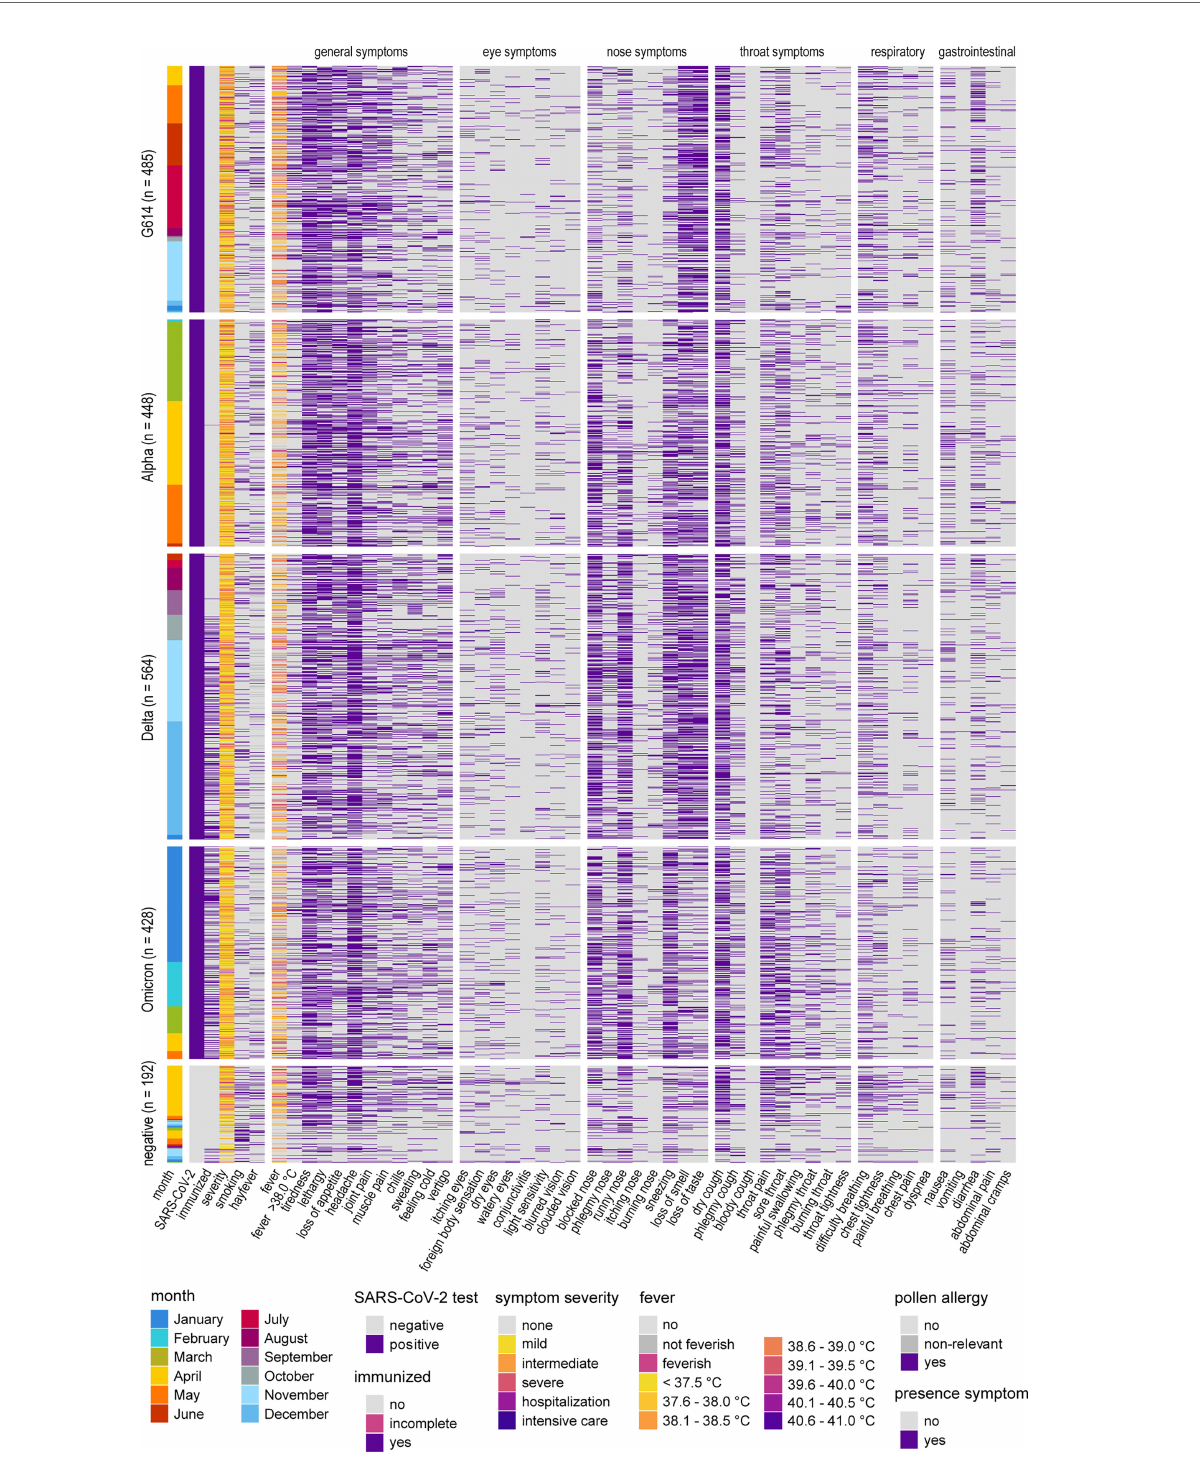
FIGURE 1 | Heatmap of symptoms reported by SARS-CoV-2 positive and negative tested individuals. Symptoms reported by SARS-CoV-2 positive (4 top sections) and SARS-CoV-2 negative individuals (bottom). Subjects were sorted according to SARS-CoV-2 test outcome and date of questionnaire completion; groups of positive subjects are displayed according to periods of dominance of SARS-CoV-2 G614 and the alpha, delta and omicron variants. “ Month ” indicates the date of completion of the questionnaire. “ feverish/not feverish ” : subjective judgement, participant did not measure their body